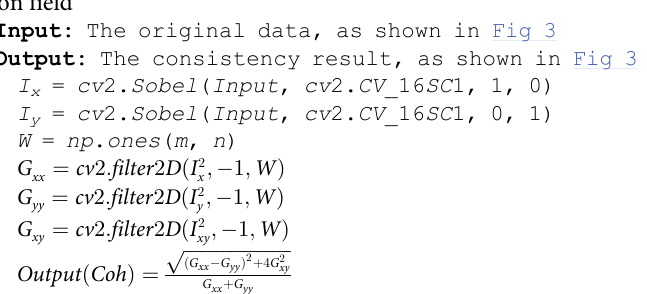
Algorithm 1 Algorithm based on OpenCV for determining the consistency of an